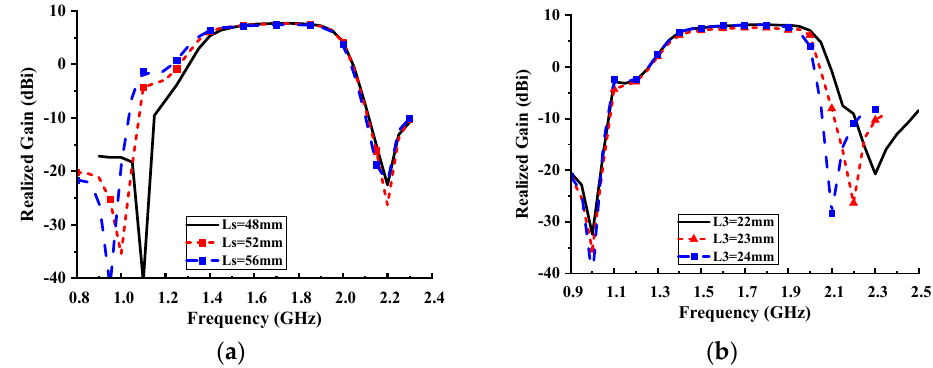
Figure 5. Simulated realized gains for different length of ( a ) the C − stub. ( b ) the U − slot.